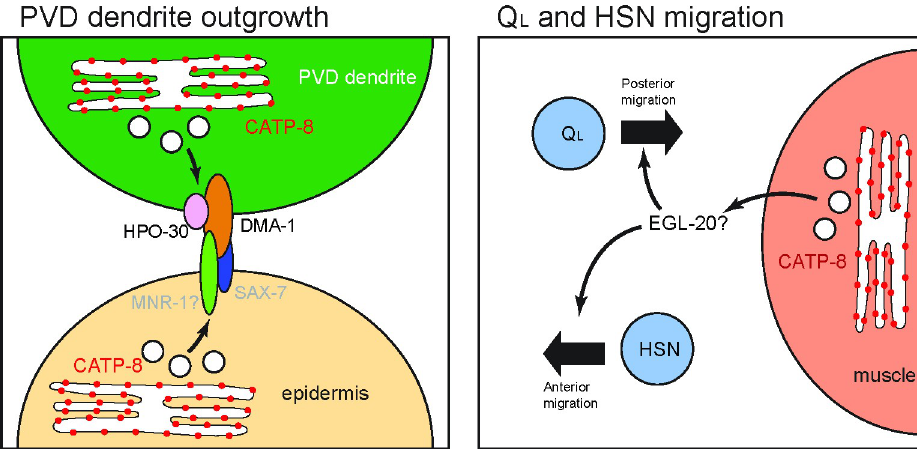
Fig 8. Graphical Model of CATP-8 functions. CATP-8 is associated with the endoplasmic reticulum and regulates or facilitates the secretary pathway. In the case of PVD dendritic outgrowth, CATP-8/P5A-ATPase is proposed to ensure the expression and localization of DMA-1 and HPO-30 in PVD, as well as transmembrane factors from the epidermis, of which one candidate is MNR-1. In the case of QL neuroblast and HSN migration, our results strongly suggest that CATP-8 ensures the sufficient secretion of the Wnt ligand EGL-20, which is needed for the posterior migration of QL neuroblasts, and the anterior migration of HSN neurons.